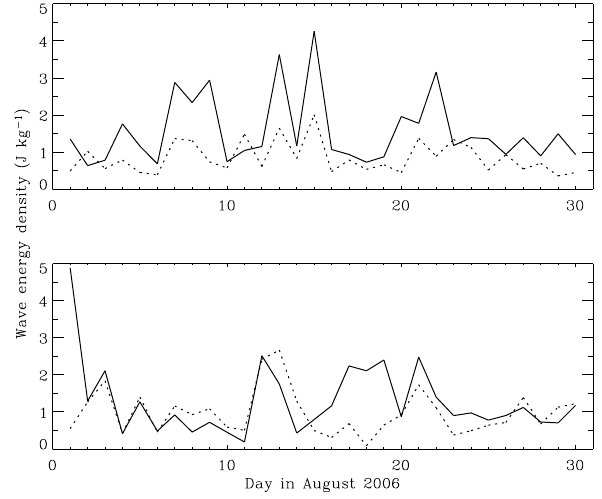
Fig. 3. Daily averaged GW kinetic energy (solid curves) and po- tential energy (dotted curves) densities in the troposphere (bottom panel) and lower stratosphere (top panel) in August